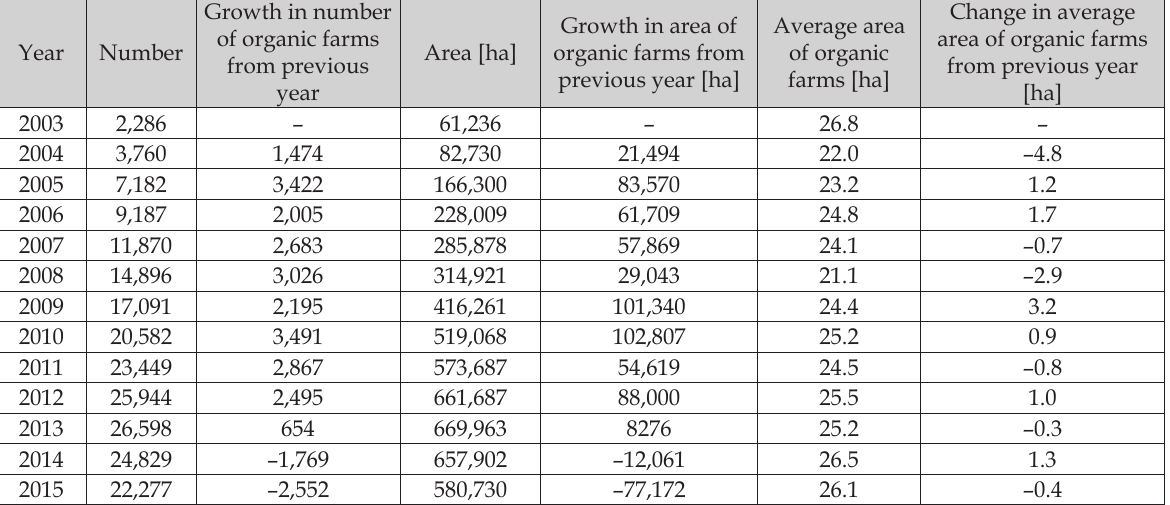
Table 2. Changes in the area of organic farmland in Poland, 2004–2015.